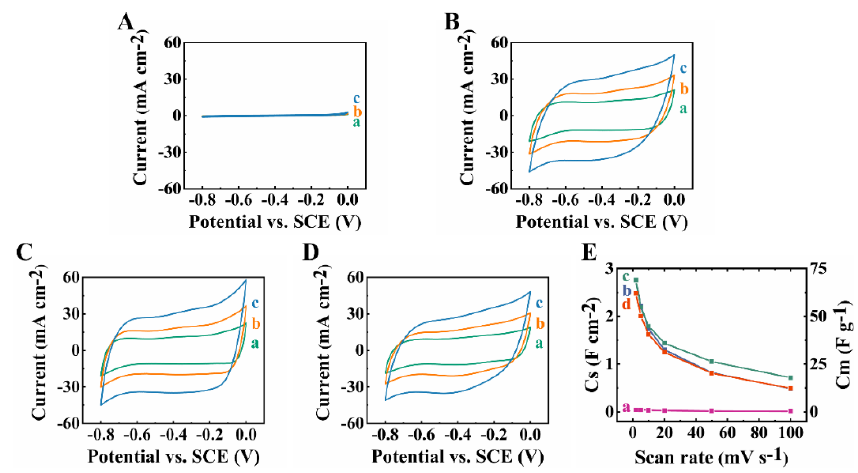
Figure 6. ( A – D ) CVs at scan rates of (a) 5, (b) 10 and (c) 20 mV s −1 for ( A ) CFO-0, ( B ) CFO-10, ( C ) CFO-20 and ( D ) CFO-30 electrodes; ( E ) capacitance versus scan rate for (a) CFO-0, (b) CFO-10, (c) CFO-20 and (d) CFO-30 electrodes.